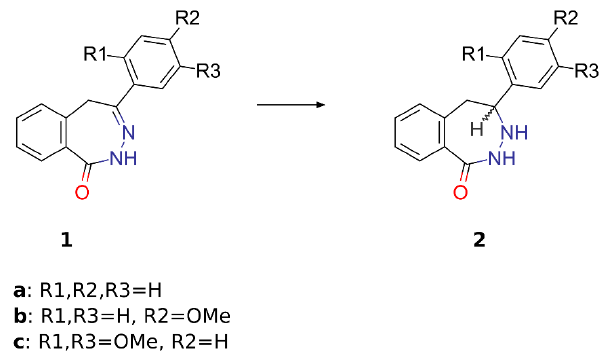
Figure 2. Hydrogenation of 2,3-benzodiazepin-1-ones. Reagents and conditions: H 2 , 10 % Pd/C, MeOH-HCl, r.t., atmospheric pressure.